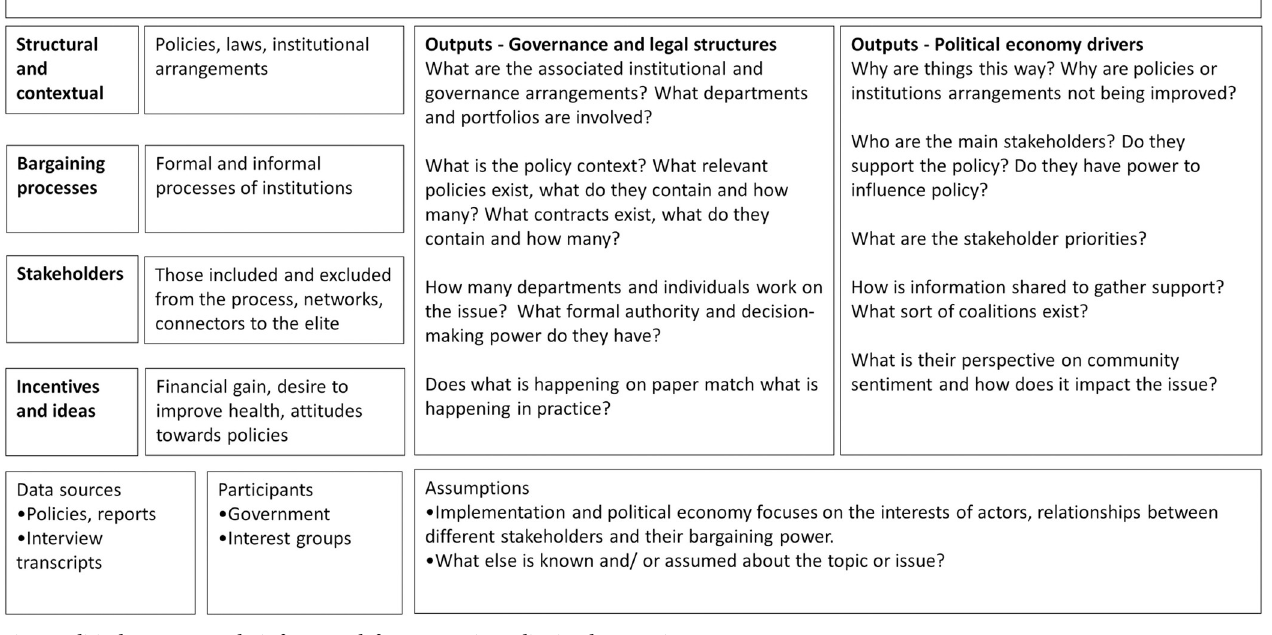
PLOS ONE | https://doi.org/10.1371/journal.pone.0274246 September 9,